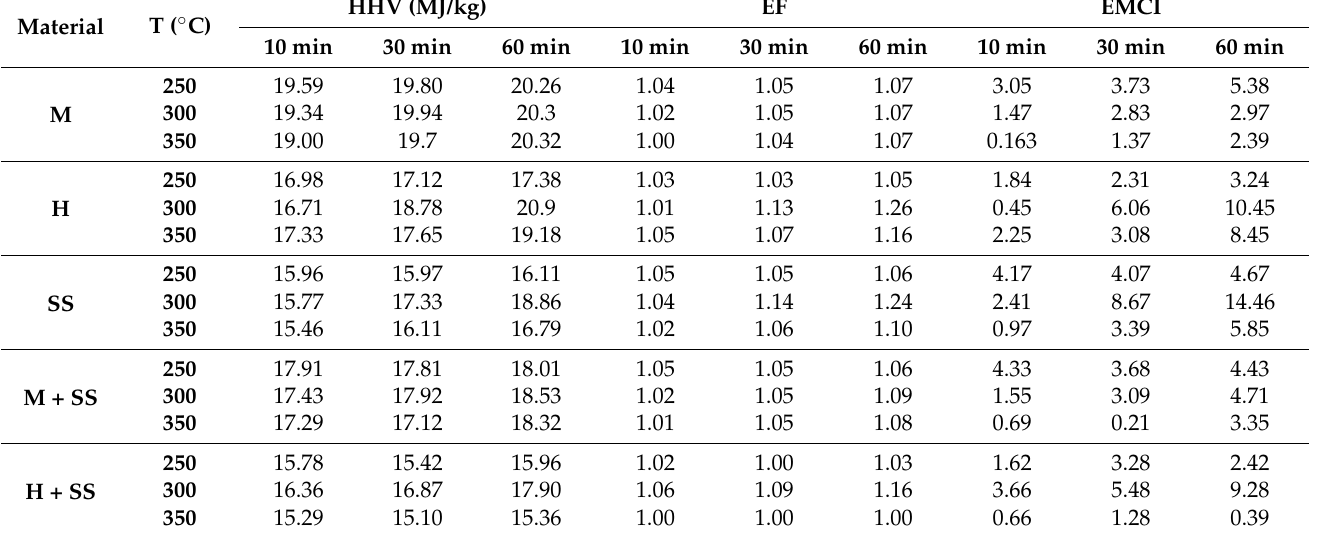
Table 4. HHV (MJ/kg) and EMCI of studied biomasses with respect to temperature and